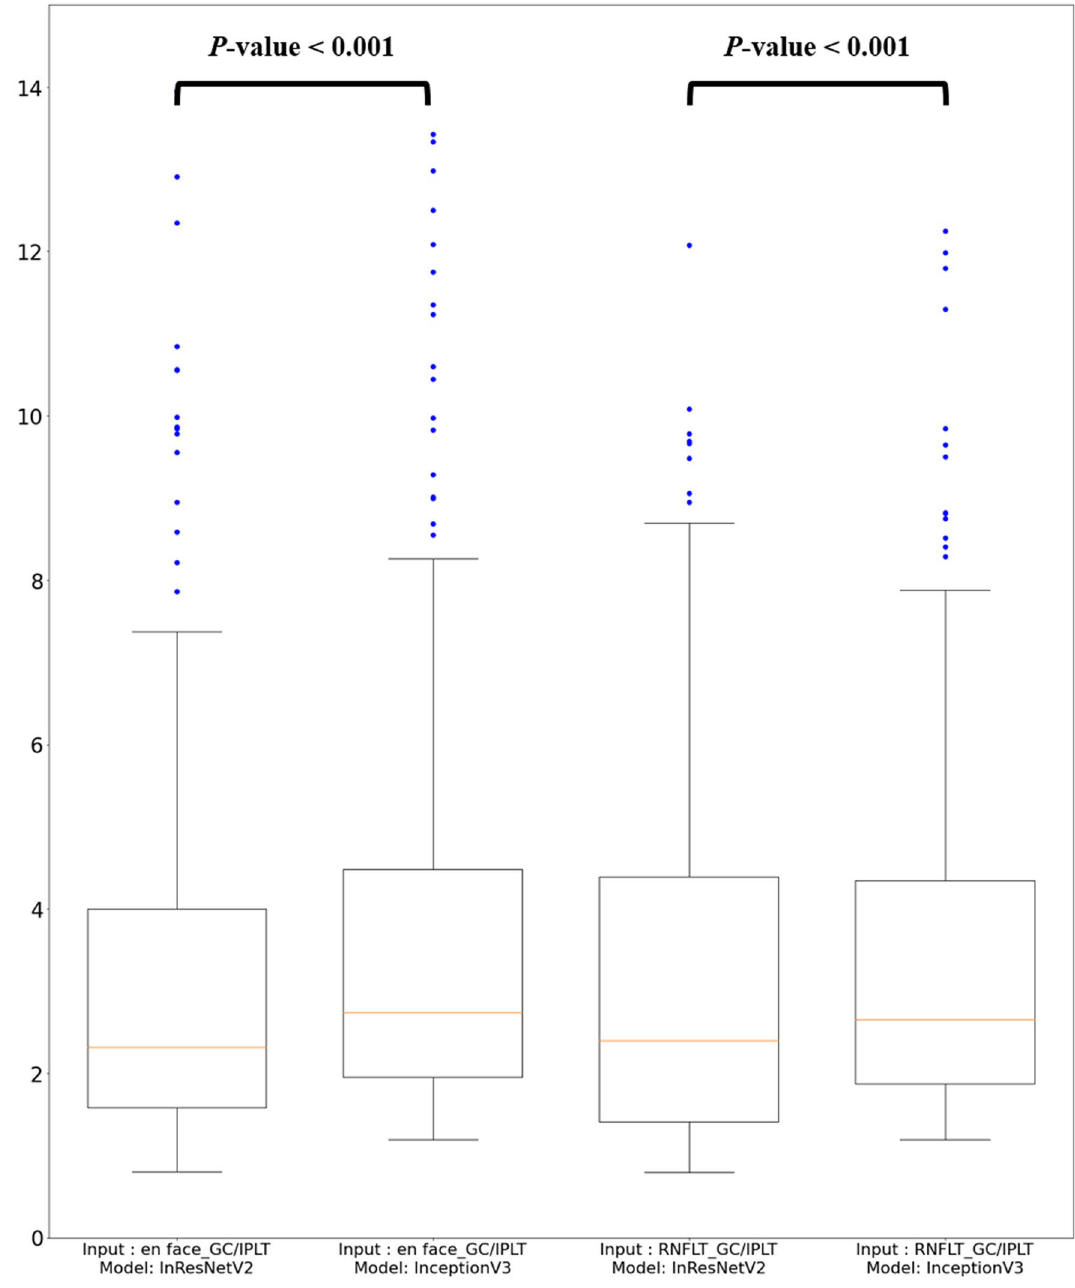
Figure 2. Global mean absolute error (MAE point-wise ) of 10-2 visual field prediction from Inception-ResNet-V2 and Inception V3. The prediction errors of Inception-ResNet-V2 were significantly lower than those of Inception V3 regardless of input images. mGC/IPLT macular ganglion cell/inner plexiform layer thickness; RNLFT retinal nerve fiber layer thickness; InResNetV2